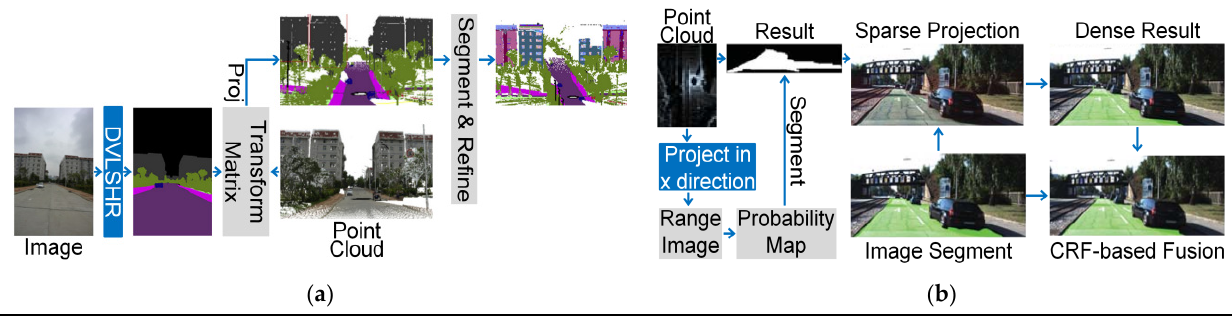
Figure 2. The representative segmentation methods using result-based fusion strategy. ( a ) The CRF-free 3D semantic segmentation result refinement method; ( b ) The CRF-based road segmentation method integrating the 2D and 3D result of road segmentation.